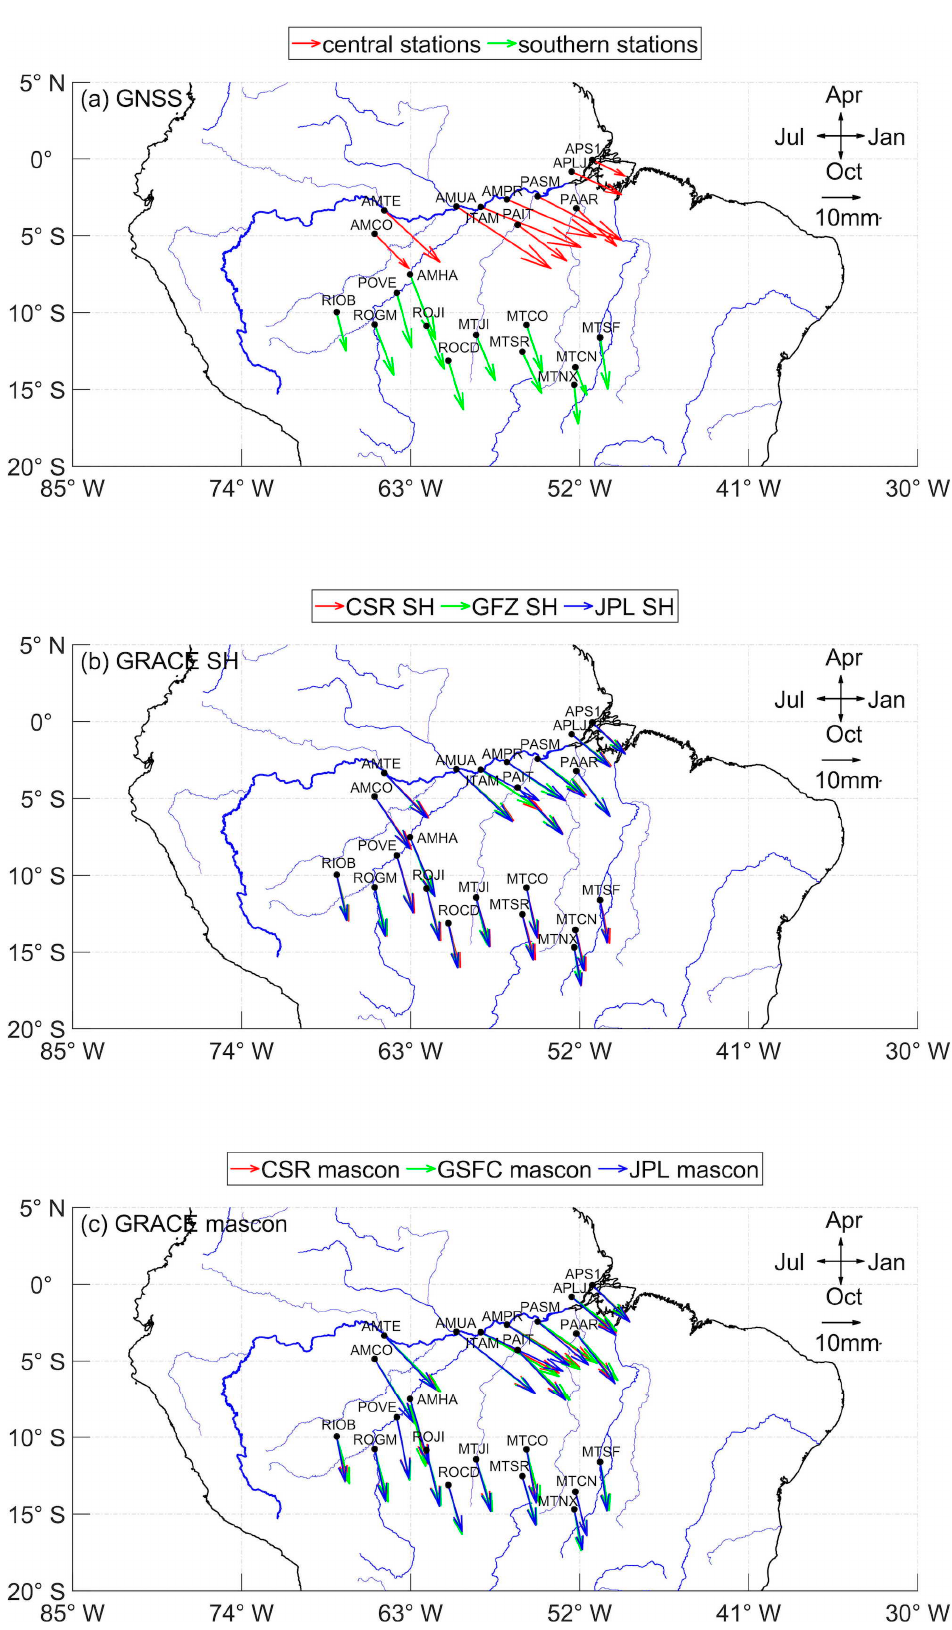
Figure 2. Annual amplitudes and phases of vertical deformation from ( a ) GNSS, and predicted from ( b ) GRACE/GRACE-FO SH solutions and ( c ) GRACE/GRACE-FO mascon solutions. The length of vector represents the value of annual amplitude, and the direction represents the peak-value counted counterclockwise from the east (from January to